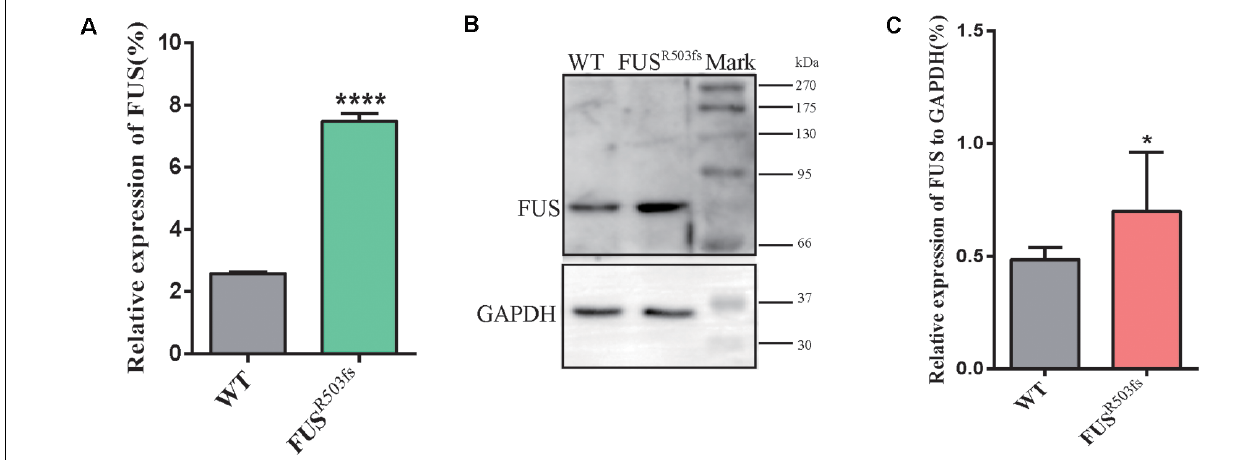
FIGURE 3 | FUS expression was significantly higher in the FUS R503fs than that in WT group. (A) The Q-rtPCR results indicated that the mRNA expression level of FUS was significantly increased in FUS R503fs compared with WT group ( n = 6, **** p < 0.0001). (B) Western blot analysis of FUS protein in neurons of WT and FUS R503fs . Molecular weight markers are shown on the right. (C) Quantification of FUS protein levels in FUS R503fs neurons was significantly increased compared with WT group ( n = 8, * p >